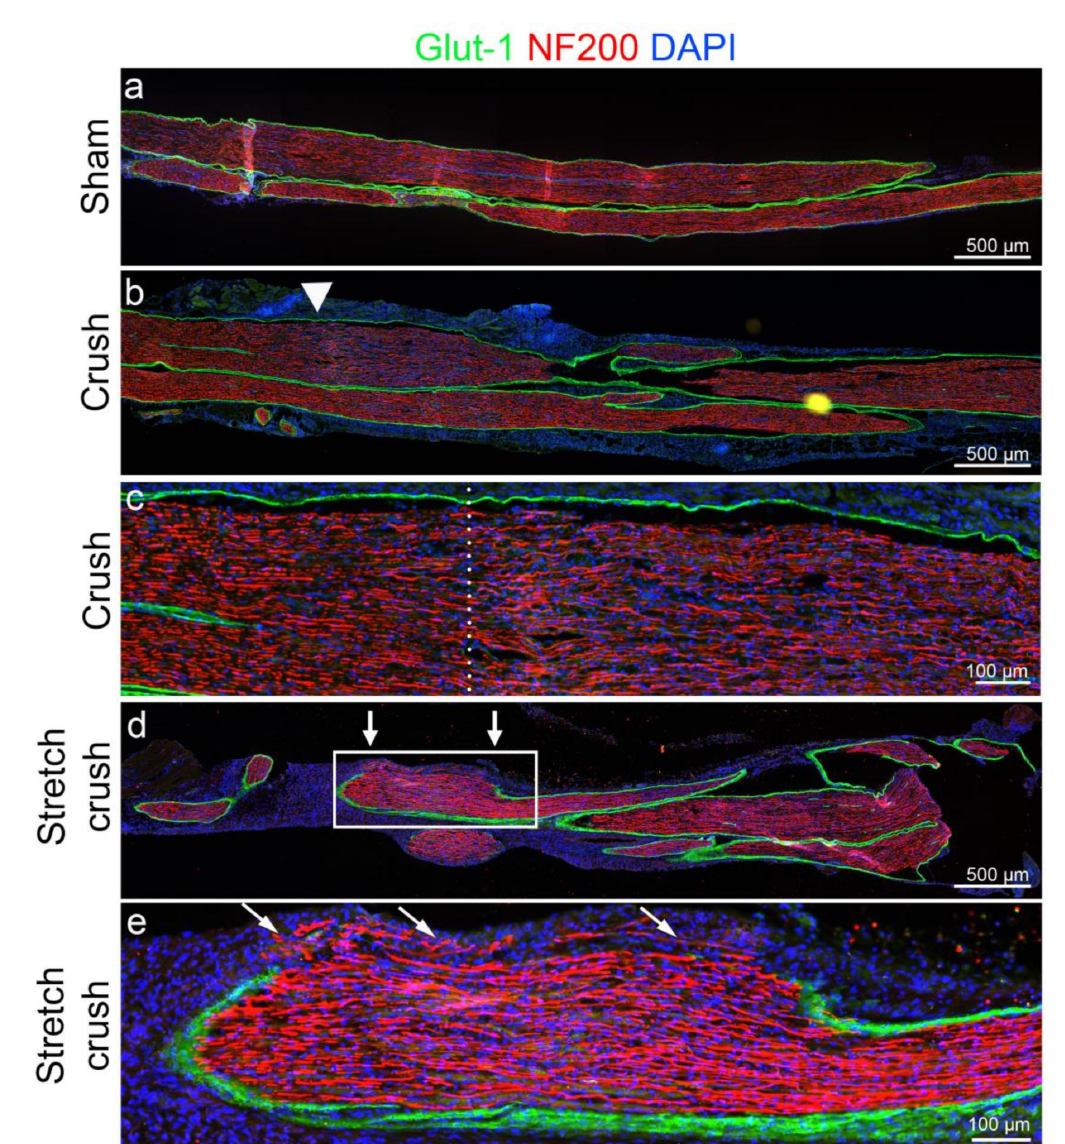
Figure 3. Histological comparison of acute six-day sciatic nerve injuries. ( a ) One-week uninjured sham nerve. ( b ) Crush injured nerve—note intact perineurium (Glut1, a marker of perineurium); yet, increased cellularity and potential inflammation related to Wallerian degeneration at and just beyond the crush site (white arrowhead). ( c ) Magnified crush-injury site of ( b ), dotted line marks the crush epicenter. Note again intact perineurium and the intense localization of nuclei (DAPI) distal (right of dotted line) to the crush site. In addition, thinned out disarrayed axons, compared to proximal to the crush zone, are evident. ( d ) Stretch–crush injured nerve. Note perineurium disruption at the injury site (between white arrows), significant nerve swelling and increased cellularity supporting an NIC development. ( e ) Magnified stretch–crush injury of ( d ), showing perineurial disruption as seen by Glut1 disruption, disarrayed axonal architecture with increased cellularity and several axons evident beyond the perineurial border—forming an NIC. NIC, neuroma in